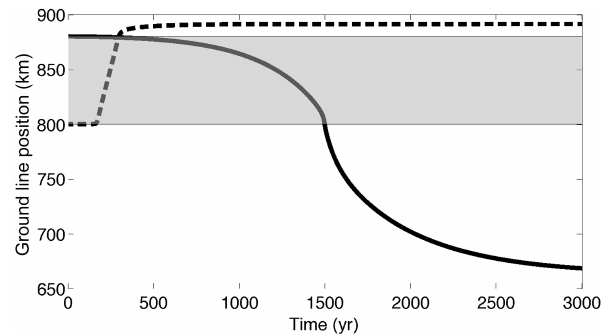
Figure 4. Transient evolution of ice-stream grounding-line po- sition with bed properties kept static ( τ c = 0 everywhere). x 0 = 800km; L = 80km; b x r = 2 × 10 − 4 . The solid line is initialized from x 0 = 881km and a c = 0 . 33myr − 1 , decreasing to 0 . 32myr − 1 over the first 300 years. The dashed line is initialized from x 0 = 799km and a c = 0 . 58myr − 1 , increasing to 0 . 59myr − 1 over the first 300